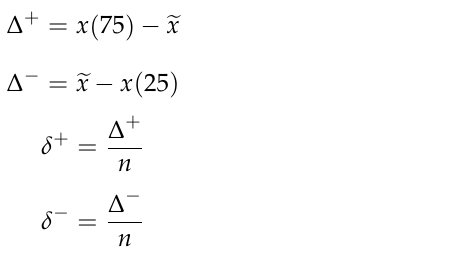
Figure 1. Example of an interval Likert five-point scale, [27]. The relative uncertainty is calculated according to Formula (4), where n is the number of elements on the sparse scale: The uncertainty asymmetry can also be expressed in absolute and relative terms. Absolute uncertainty is expressed from the right by Formula (5), from the left by Formula (6), relative to the right by Formula (7) and relative to the left Formula